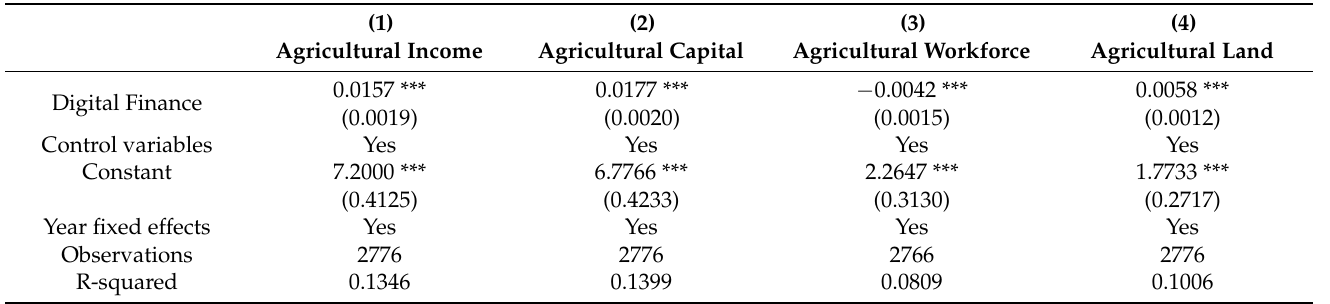
Table 6. Digital finance and agricultural production factors.